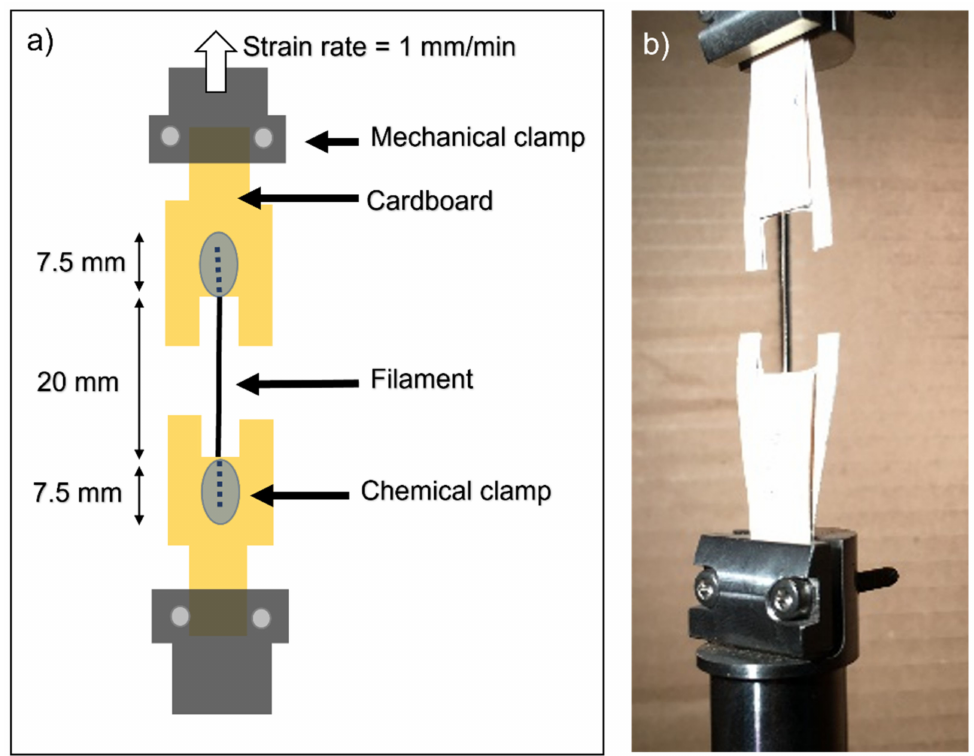
Figure 2. ( a ) Scheme of the tensile test sample and clamping methods. ( b ) Picture of the actual tensile test